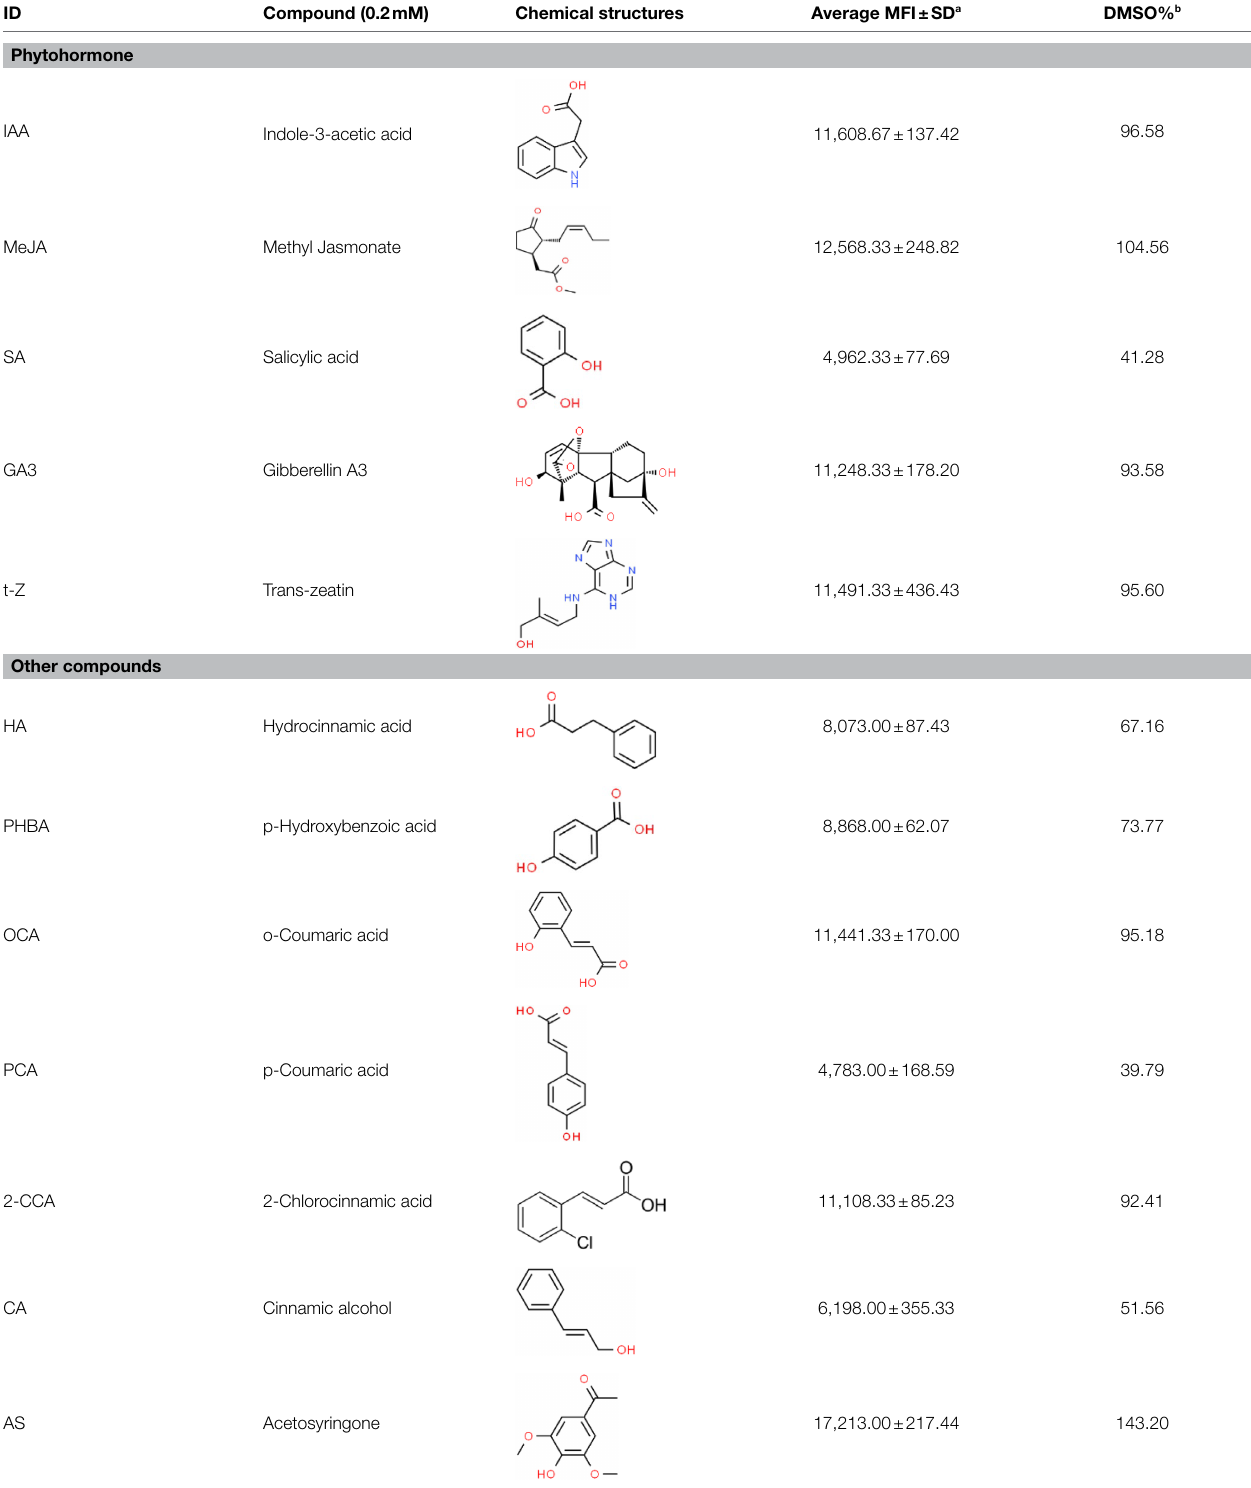
TABLE 1 | Screening for inhibitors of Dickeya zeae MS2 type III secretion system (T3SS) by Multifunctional Microplate